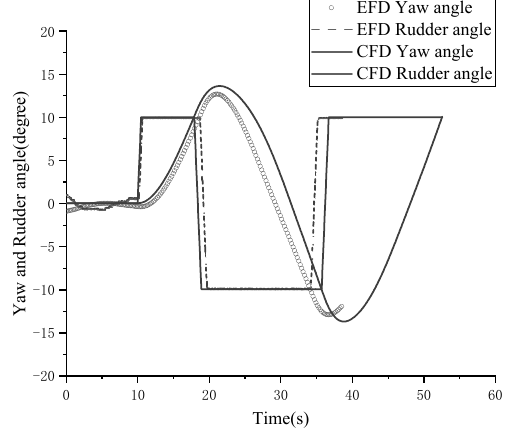
Figure 23. Heading and rudder angle in 10 ◦ zigzag maneuver.